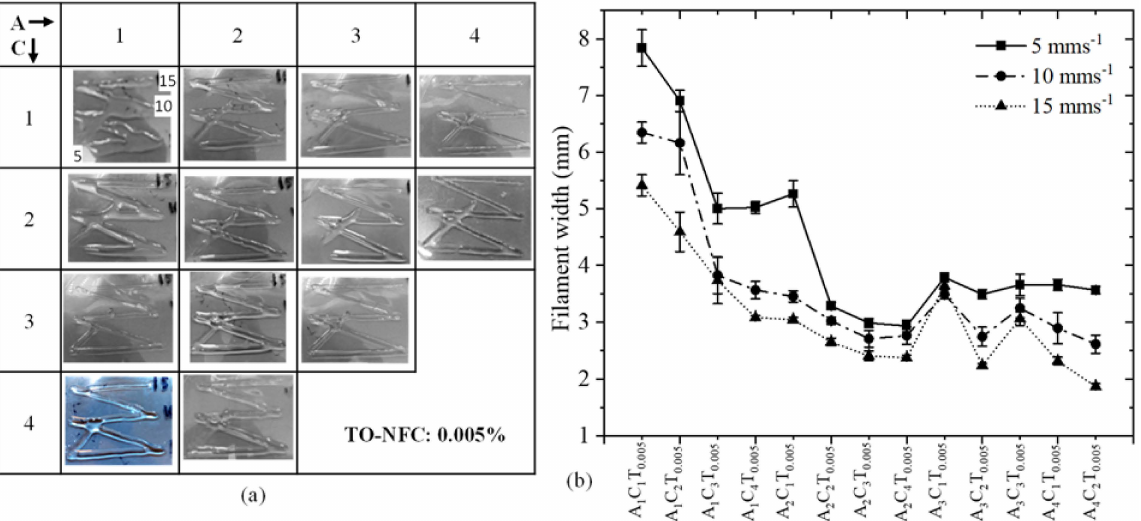
Figure 11. ( a ) Fabricated filaments with 1%, 2%, 3%, and 4% alginate; 1%, 2%, 3%, and 4% CMC; and 0.005% TO-NFC. ( b ) Filament widths of all those compositions.